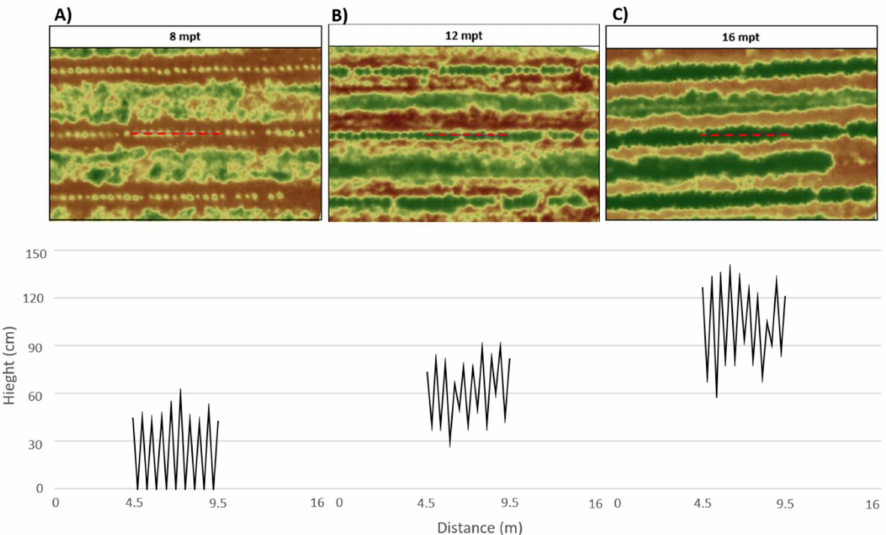
Figure 4. Temporal height profile, in centimeters (cm), of 10 sample plants considering 3 different periods of study, according to the dashed red graphic line for: ( A ) 8 mpt, ( B ) 12 mpt, and ( C ) 16